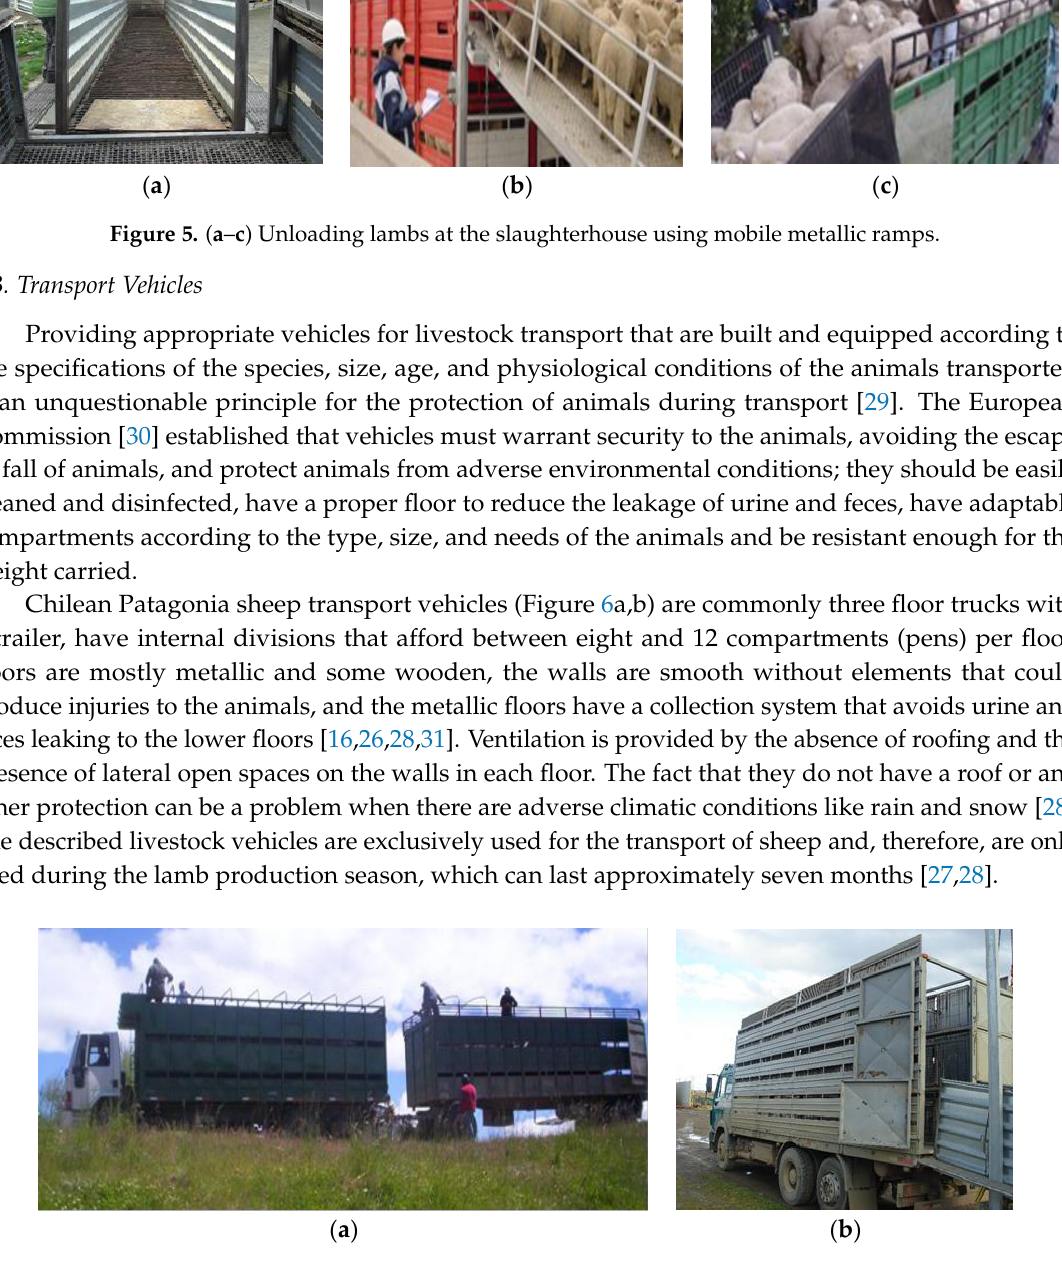
Figure 6. ( a , b ) Typical vehicles used in the Chilean Patagonia for the transport of lambs.